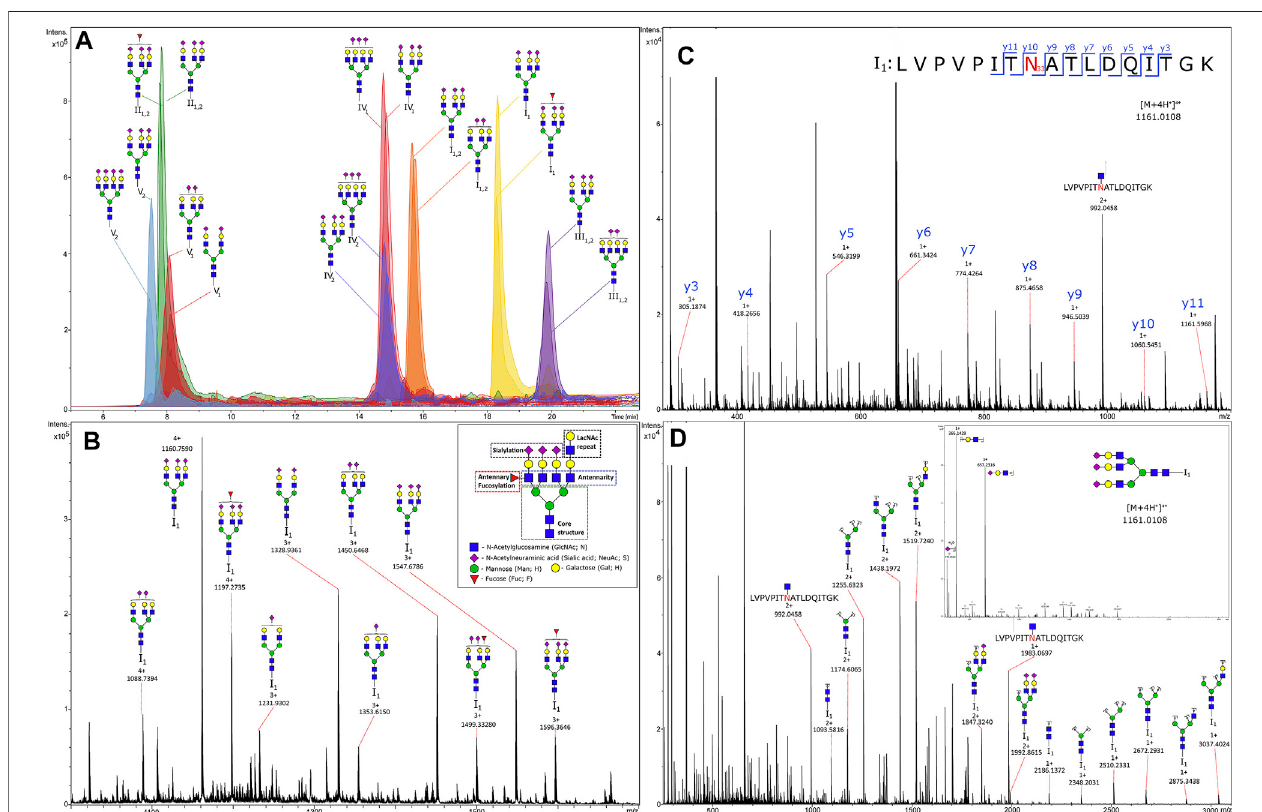
FIGURE5| Chromatogram (A) andtandemmassspectraofglycopeptides (B) ,MS 1 ofglycoformsfromglycosylation siteI 1 ; (C) ,MS 2 ofthepeptidepart; (D) ,MS 2 of the glycan (N-acetylglucosamine) 5 (Hexose) 6 (Sialic acid) 3 ) from human alpha-1-acid glycoprotein enriched from plasma. Reproduced from Keser, T., Tijardovi ć ,